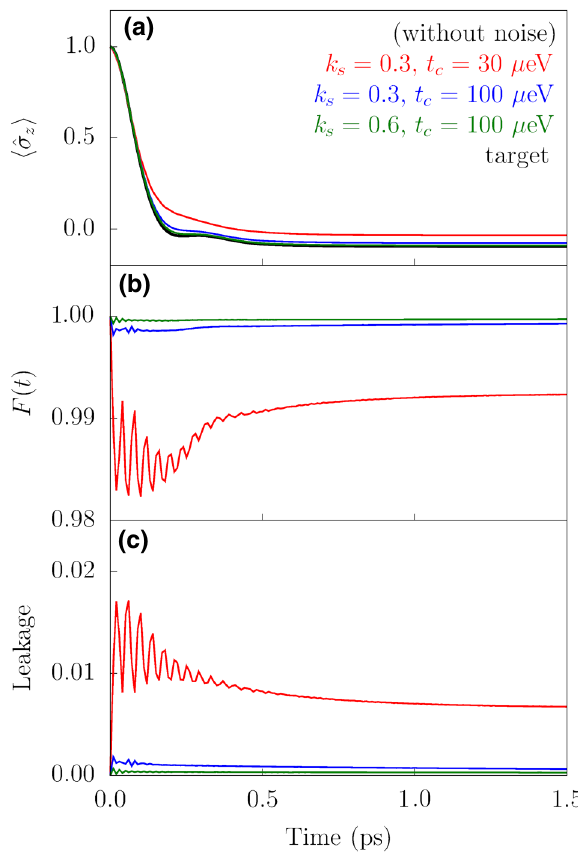
FIG. 3. Performance of the quantum simulator for three dif- ferent sensitivities k s and tunnel couplings t c . (a) Population inversion (cid:4) σ z ( t ) (cid:2) in the target dynamics (black line) and the simu- lator (colored lines). (b) Fidelity F ( t ) of the simulation. (c) Total population leaked out of the simulation subspace. Time is physi- cal time. Simulation time is obtained by scaling by γ = 5 × 10 3 . In Fig. 4(a), the three specific choices of k s and t c used are marked by the colored (red, blue, and green)